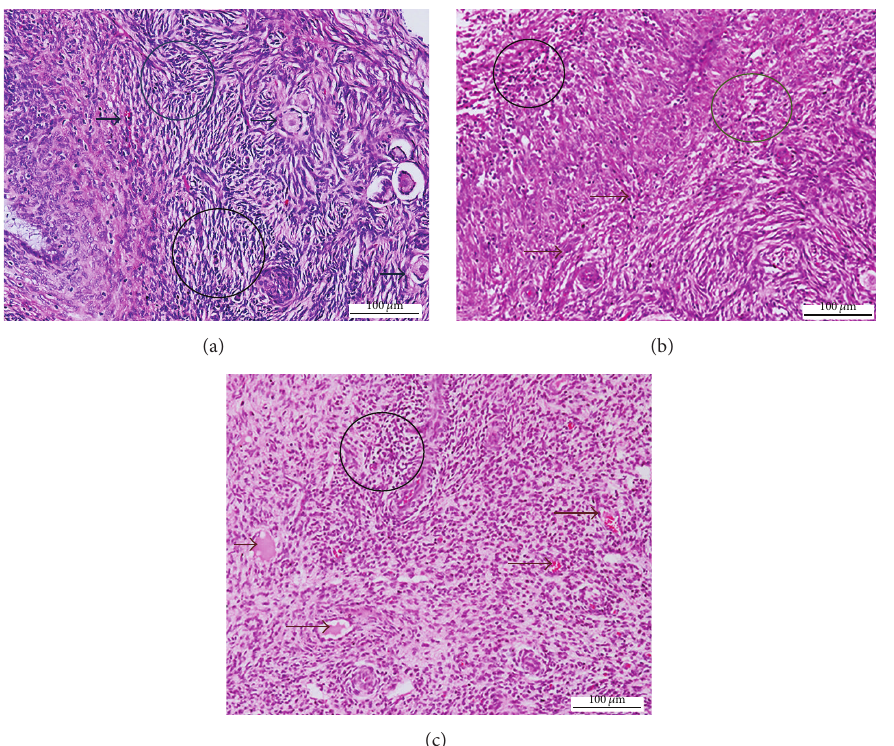
Figure 1: Photomicrograph section of the ovary of nonpregnant does inoculated with Corynebacterium pseudotuberculosis : (a) inflammatory and necrotic cells (circle) following intranasal inoculation; (b) inflammatory and necrotic cells (circle), congestion (brown arrows), following oral inoculation; (c) congestion (black arrows), inflammatory and necrotic cells (black circle), following intradermal inoculation (H&E × 200). Table 2: Mean scores of histopathological changes in uterus of nonpregnant Boer does experimentally inoculated with C. pseudotuberculosis . Group Parameters Control Intradermal Intranasal Oral